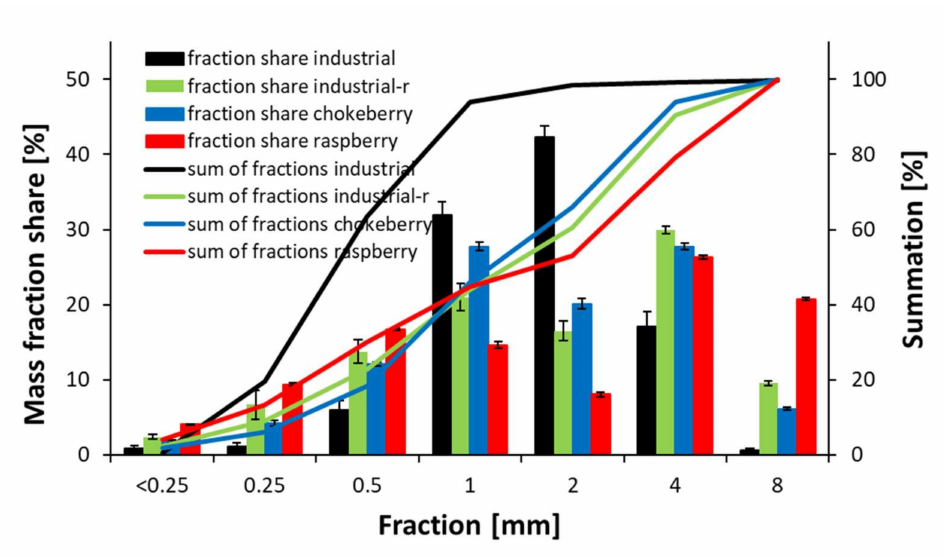
Figure 12. Mass fraction share of particles produced by re-milling of composites considering indus- trial